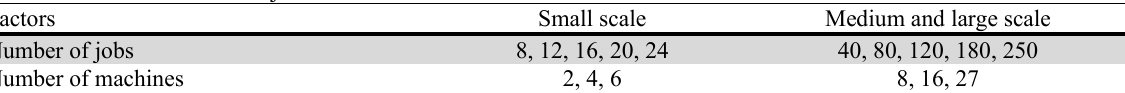
The Number of machines and jobs